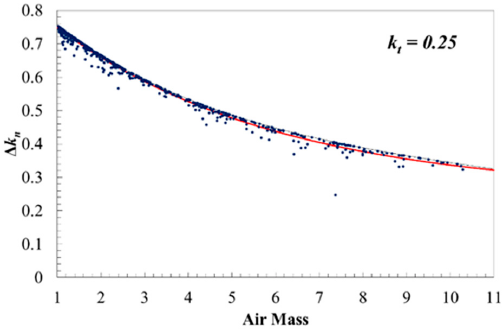
k and the air mass at 0.25 = k , in which the solid red curve represents Figure 3. Scatterplot of Δ Figure 3. Scatterplot of ∆ k n and the air mass at k t = 0.25, in which the solid red curve represents the n t k in Equation (7). the regression fit and the black thin curve represents regression fit and the black thin curve represents k nc in Equation nc